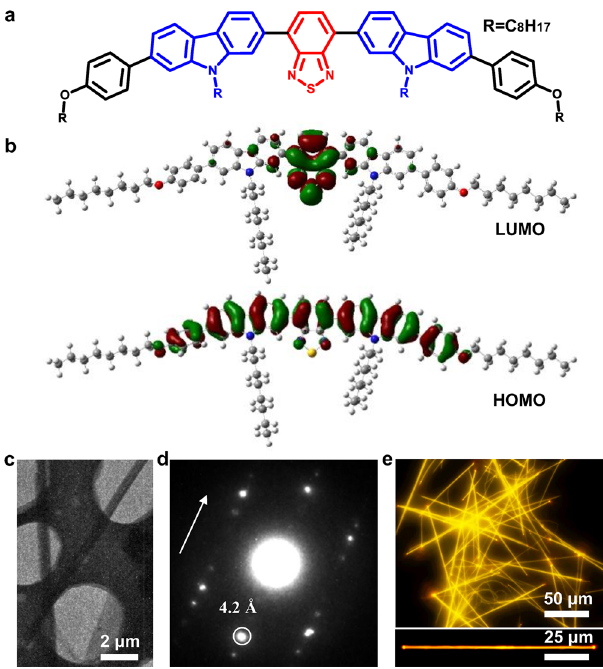
Fig. 1 Molecular design and characterization of BPCBT microwires. a Chemical structure and b molecular orbital diagrams (LUMO and HOMO) of BPCBT. c TEM image of BPCBT microwires. d Corresponding SAED pattern. e Fluorescence microscopy images of large-area BPCBT microwires and a single